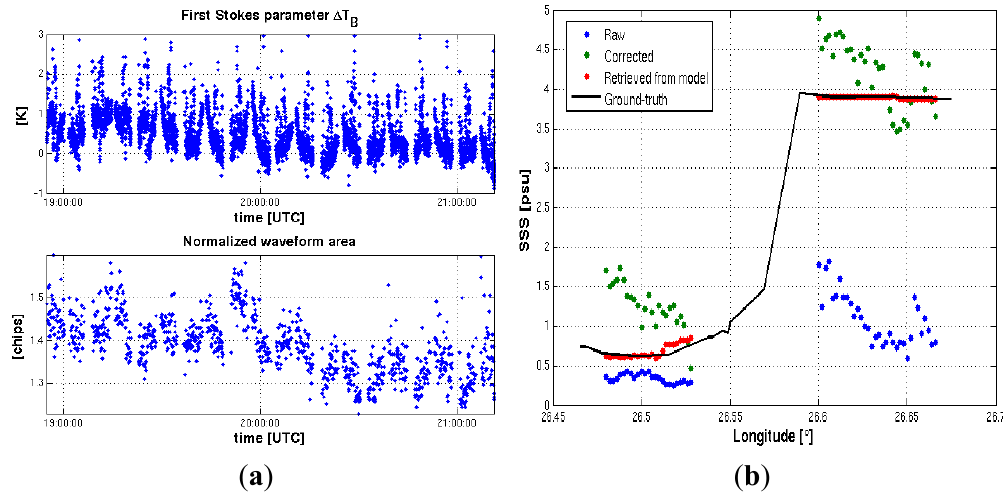
Figure 20. ( a ) Instantaneous variations of the first Stokes parameter (TUD’s EMIRAD nadir looking antenna) and area under the normalized waveform (same philosophy as explained for the DDM volume, but in the experiment IEEC’s GOLD-RTR did not compute DDMs); ( b ) Retrieved sea surface salinity values using GNSS-R data. Data from COSMOS-OS field experiment generously provided by ESA (from